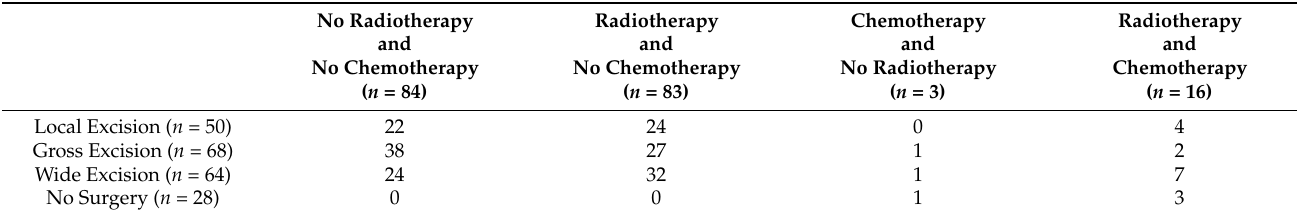
Table 3. Summary of the treatment